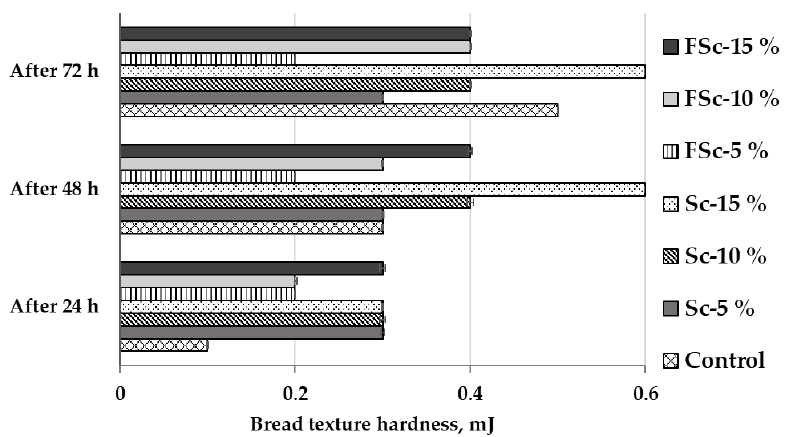
Figure 2. Bread texture hardness (mJ) after 24, 48 and 72 h of storage. Control—bread prepared without scald or fermented scald; Sc—scalded rye flour; FSc—scalded-fermented rye flour; 5%, 10% and 15%—bread prepared with 5%, 10% and 15%, respectively, scalded (Sc) or scalded-fermented (FSc) rye wholemeal flour.